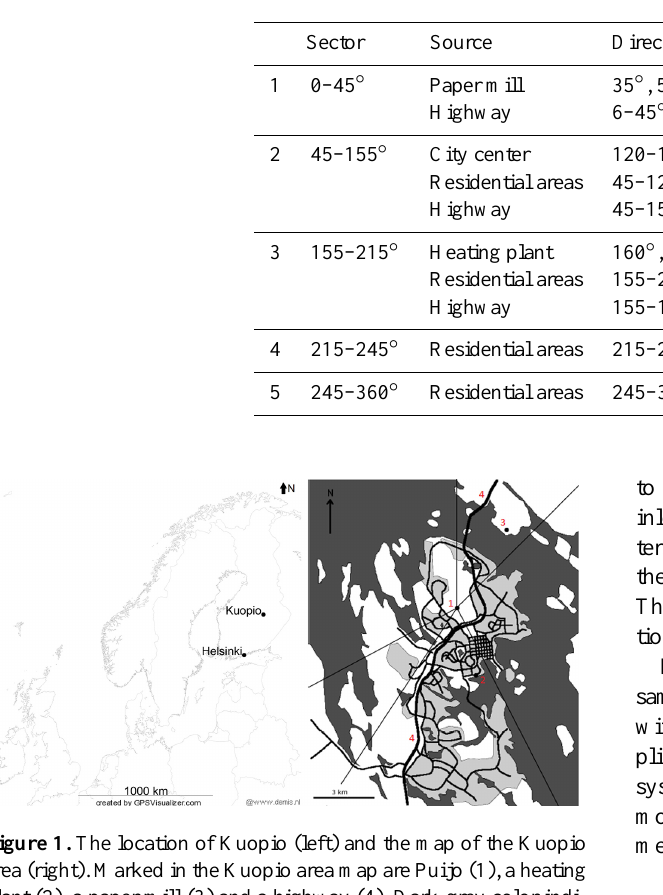
Table 1. Sectors used for data classification and a list of local sources.